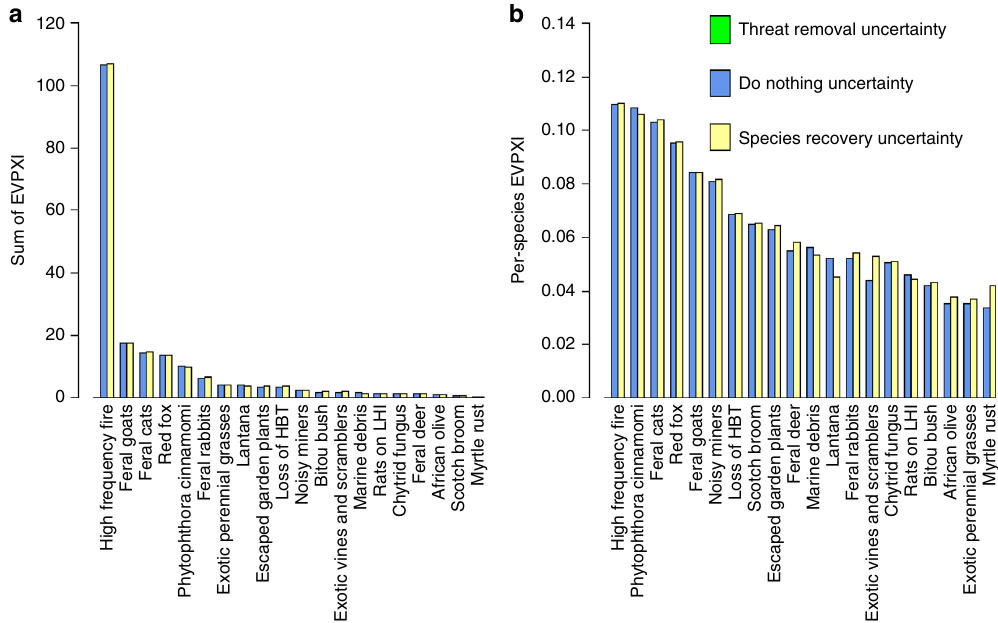
Fig. 6 Cumulative expected value of partial information (EVPXI) for each threat. Colours indicate the contribution of each type of uncertainty; the length of the stacked bars indicates the size of the EVPXI for each uncertainty. Panel a depicts the average total additional gain in persistence for all species affected by the threat compared to the bene fi t of best management under uncertainty. Panel b depicts the per-species gain in persistence. In this study, reducing uncertainty about threat removal (green in the fi gure legend) has negligible value of information so does not appear in the